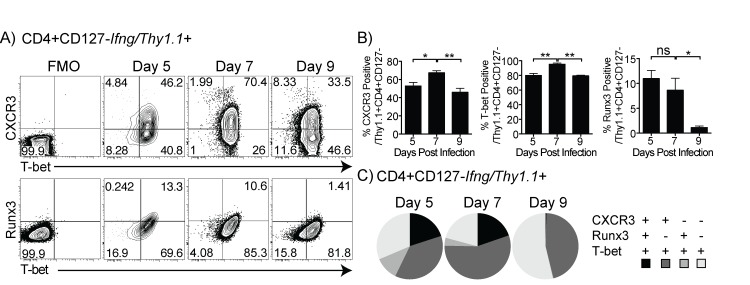
Expression of markers of Th1 differentiation is reduced at the peak of IFN-γ production.
Ifng/Thy1.1 KI mice were infected with P. chabaudi iRBC, and splenocytes were analyzed. (A) Contour plots show expression of CXCR3, T-bet, and RUNX3 gated on CD4+
Ifng/Thy1.1
+ on days 5, 7, and 9 post-infection. The numbers depicted on the plots are average percentages. Gates were drawn using fluorescence minus one (FMO, CXCR3) or isotype (T-bet, Runx3) controls for each day, as shown to the left. (B) Bar graphs showing percentages of CXCR3, T-bet, and RUNX3 positive cells in Thy1.1+ Teff population on each day. Data is summarized in (C) pie charts of Boolean gating analysis of all possible combinations of CXCR3+, Runx3+, and T-bet+ within CD4+
Ifng/Thy1.1
+ effector T cells. Ifng/Thy1.1
+ T cells expressing all three Th1 markers are shown in black. Two markers are shown in dark grey, and one marker is indicated by light grey. Data are representative of three independent experiments with three animals per timepoint. Statistical significance was obtained using Students t test. Error bar represents SEM; ★
p < 0.05, ★★
p < 0.01, ns = not significant.